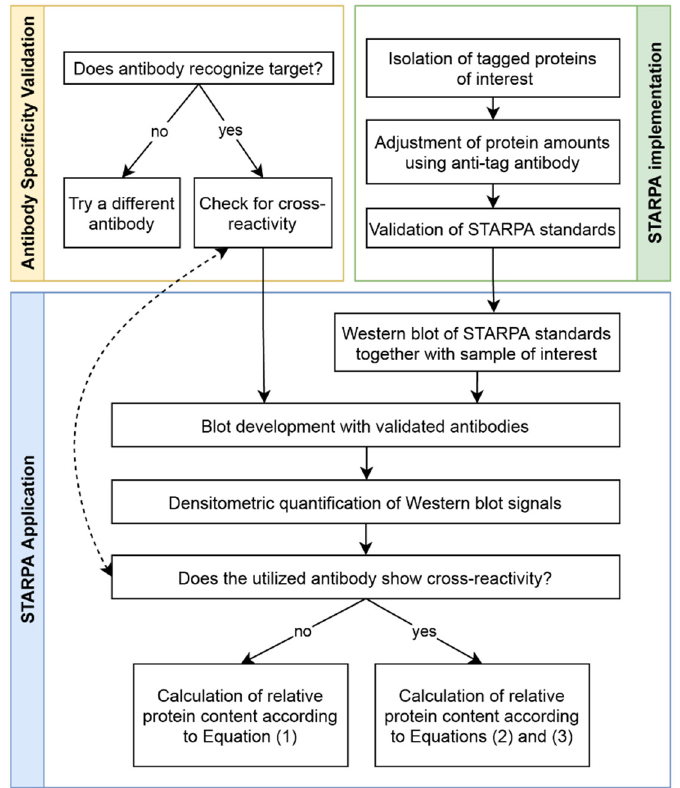
Figure 6. Sequence of events needed to conduct STARPA experiment. Antibody validation (orange) and STARPA implementation (green) are prerequisites to applying STARPA (blue).